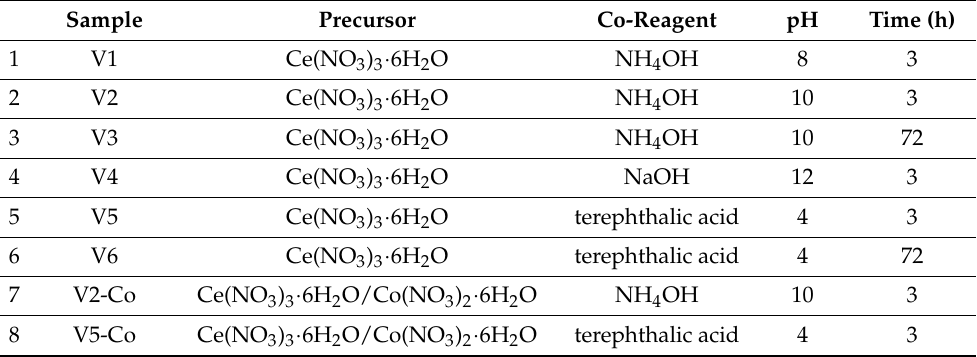
Table 1. Experimental parameters for the preparation of undoped/doped CeO 2